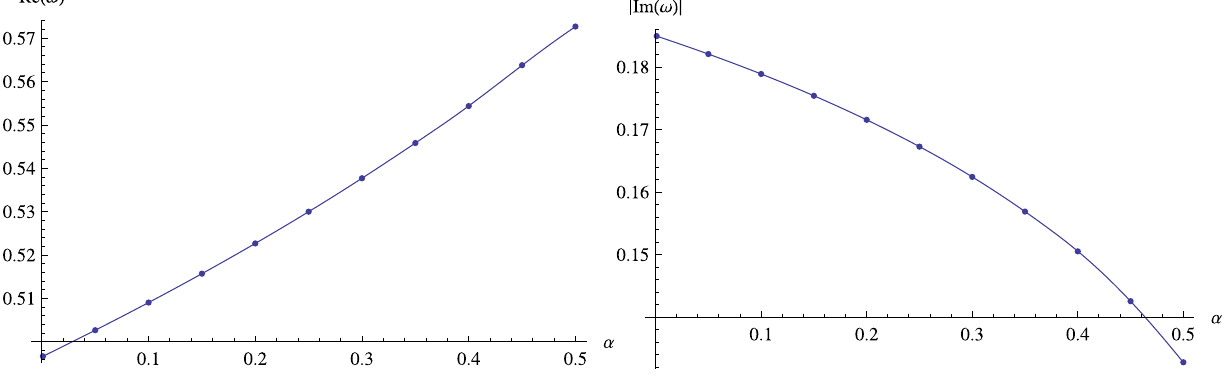
Fig. 2 The fundamental ( n = 0) quasinormal mode computed by the WKB approach for (cid:11) = 1 electromagnetic perturbations as a function of α , M = 1 /